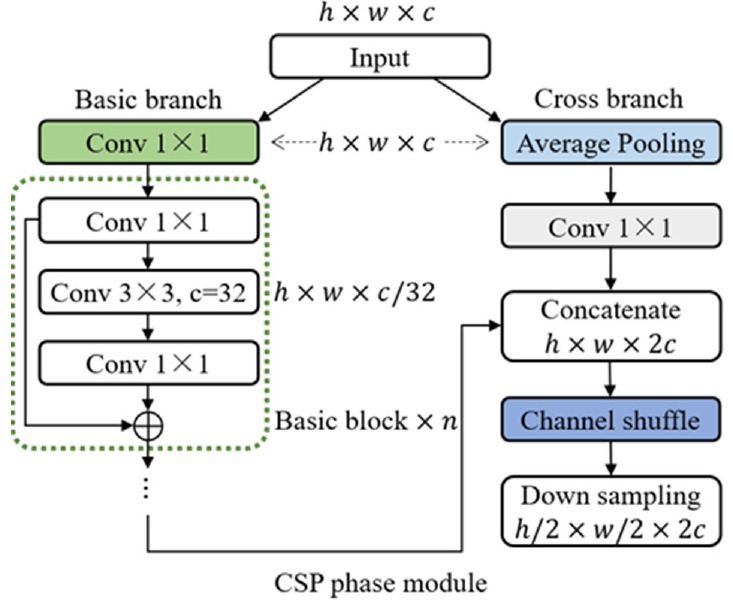
Figure 2. Fine-tuned backbone network via CSP-Net Figure 2. Fine ‐ tuned backbone network via CSP ‐ Net structure.